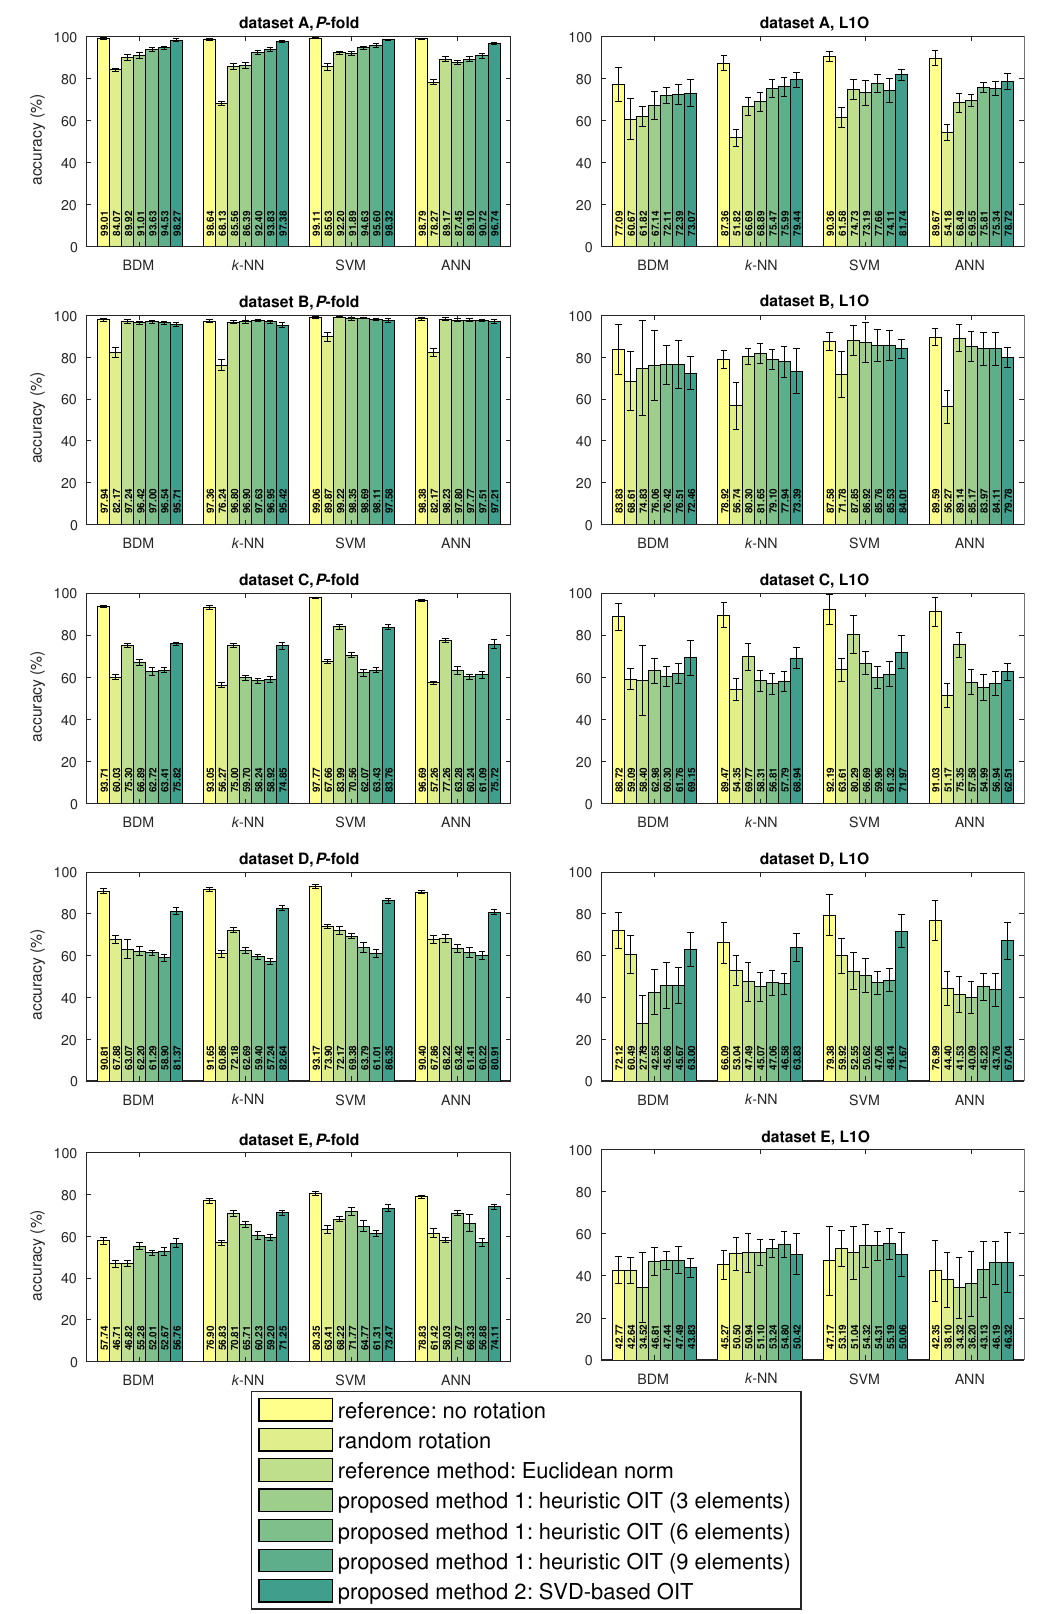
Figure 7. Accuracies shown as bars or horizontal lines for all the cases, datasets, classifiers, and cross-validation techniques. The vertical sticks indicate plus/minus two standard deviations around the mean over the cross-validation